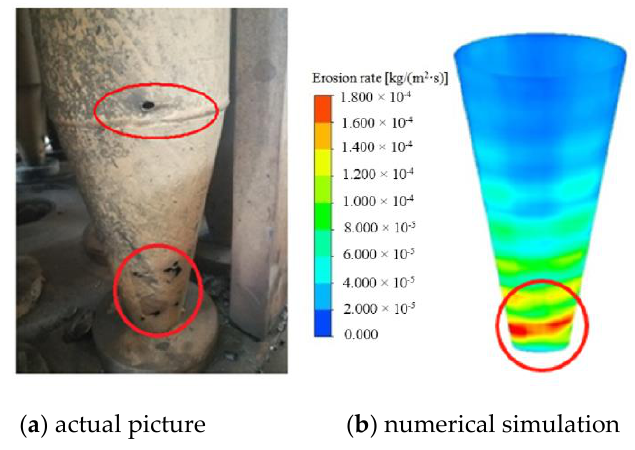
Figure 9. Comparison of the cone erosion location.